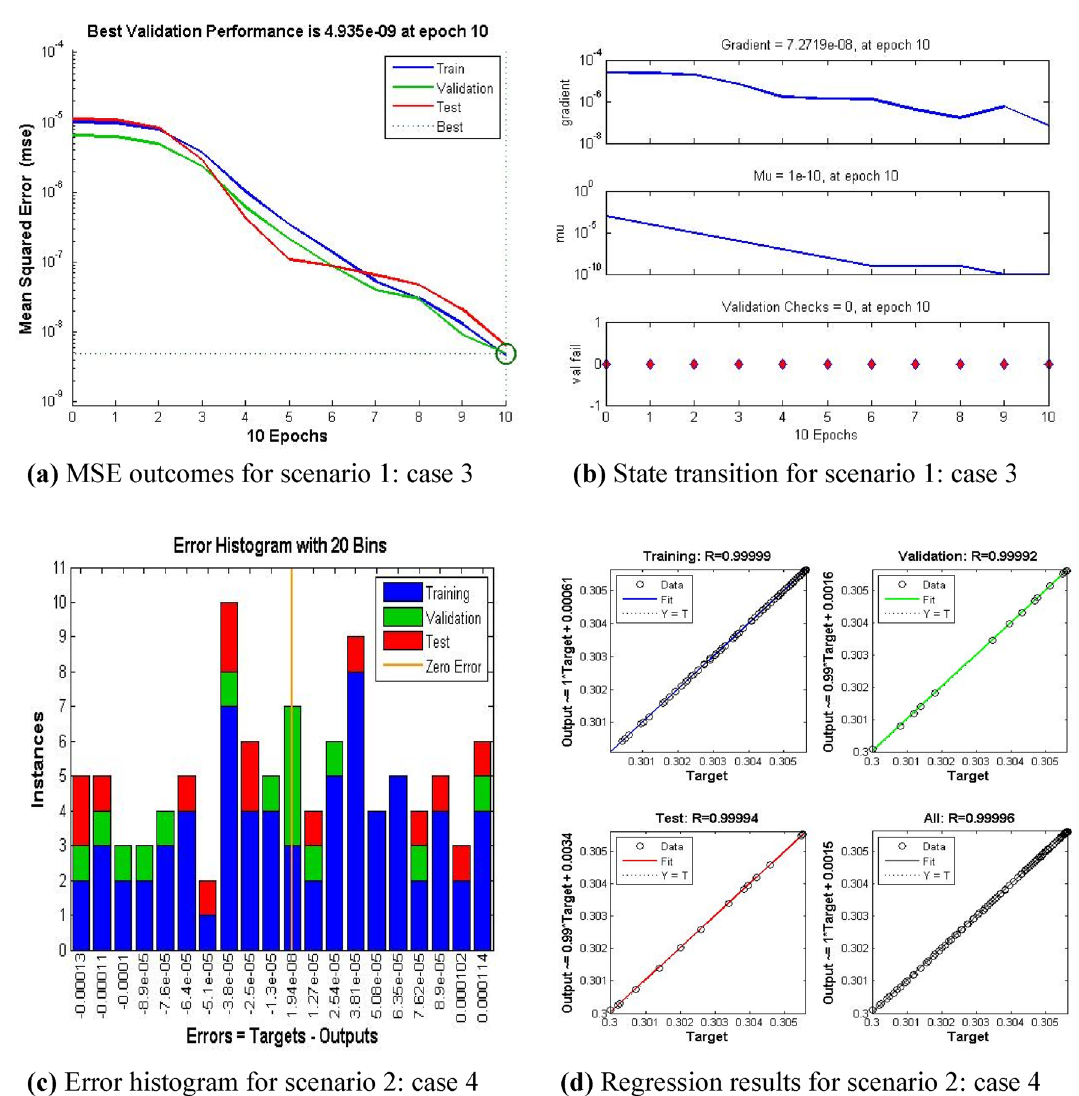
Figure 3. ANNs-BRS outcomes for solving the hybrid nanofluid flow model in scenario 1 case